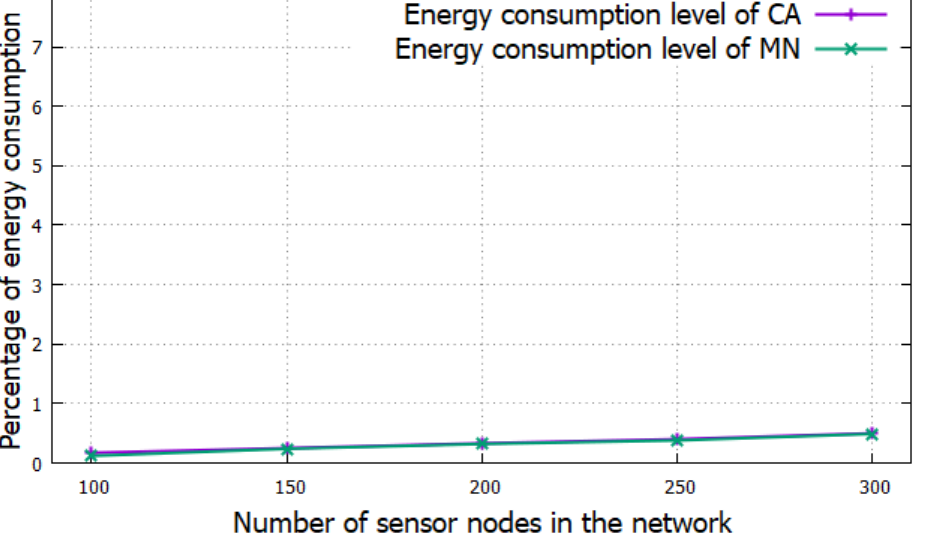
Figure 8. The lifetime of the CA as a function of the percentage of malicious sensor nodes.